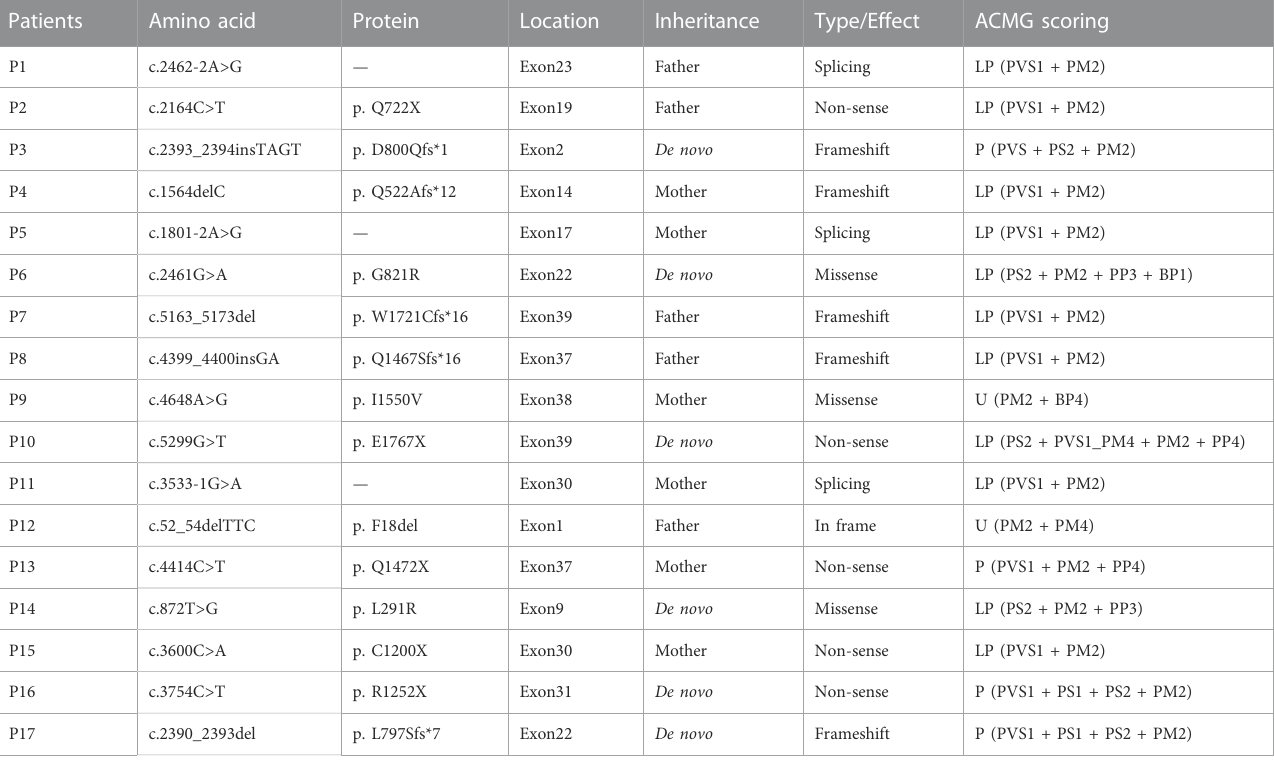
TABLE 1 Mutations of the ANK1 gene identi fi ed in 17 patients with hereditary spherocytosis.